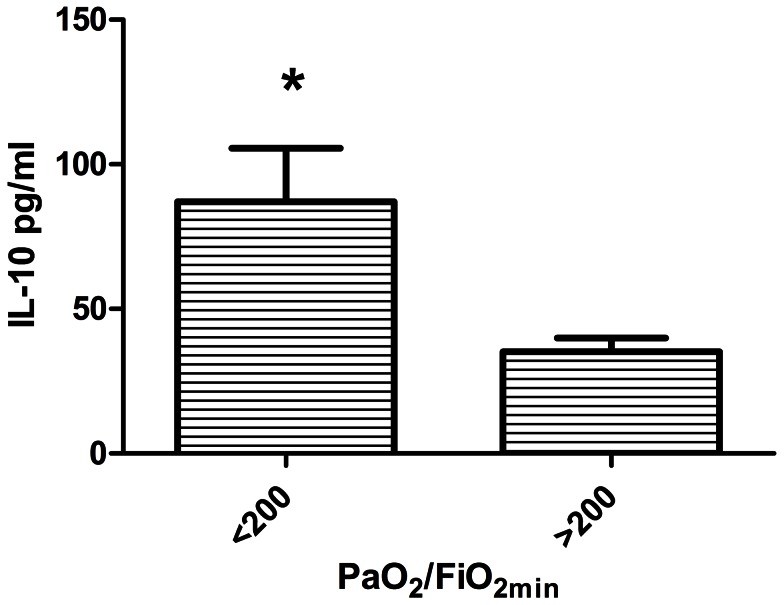
Comparison of averaged early (<72 hr post injury) IL-10 concentrations in mainstem bronchial washings, between the lowest PaO2/FiO2 ratios ratios during the first 2 weeks post injury (PaO2/FiO2) of <200 (N = 16), and patients with PaO2/FiO2 ≥200 (N = 24).Bars represent mean ± SE. * P<0.05, t-test with Welch's correction for unequal variances.